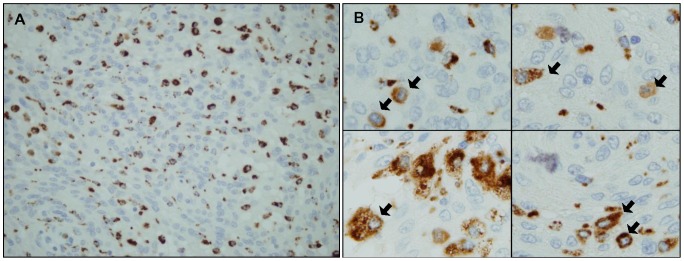
Immunohistochemical staining of meningioma tissues with the anti-CD68 antibody.CD68-positive cells detected within the tumor parenchyma showed reactivity in their cytoplasm and a mononuclear cell appearance, compatible with macrophages infiltrating the tumor. An overview of the whole tissue from a representative case (original magnification, ×400) (panel A) and a higher amplification of areas containing CD68-positive cells (original magnification, ×1000) (panel B), are displayed.